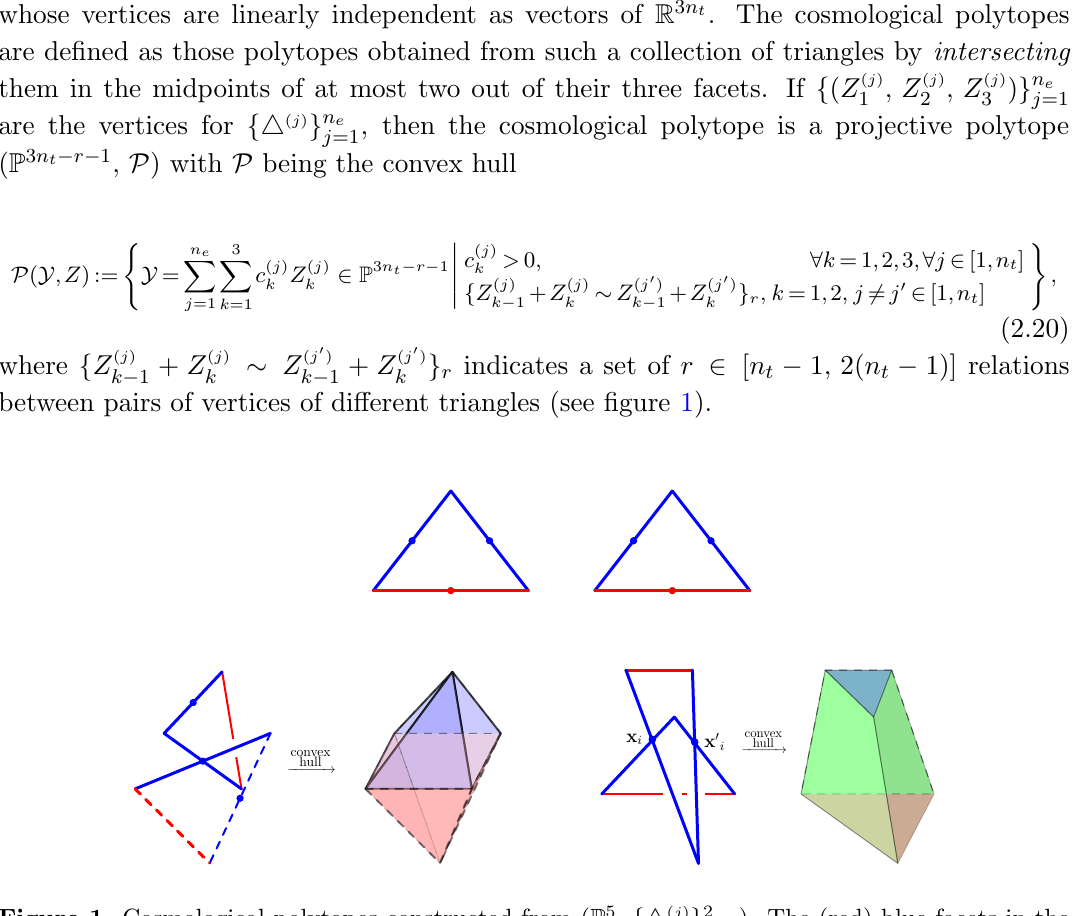
Figure 1 . Cosmological polytopes constructed from ( P 5 ; f4 ( j ) g 2 triangles indicate the ones which can(not) be intersected . The (cid:12)gures at the bottom left and bottom right depict the convex hull of the vertices of triangles after one and two linear relations has been respectively imposed, so that the (cid:12)rst one lives in P 4 and the second in P 3